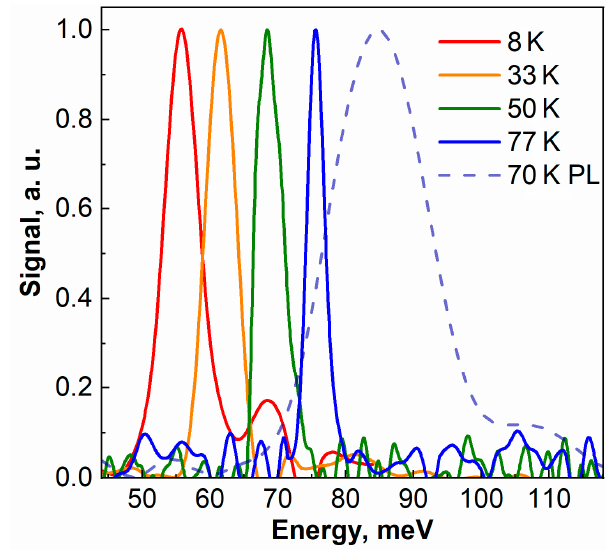
Figure 6. SE and PL spectra for str. #B0225. The SE spectra were obtained under pumping with pulsed CO 2 laser (10.6 wavelength µ m) at pumping intensity of 30 kW/cm 2 (8 K and 33 K) and 100 kW/cm 2 (50 K and 77 К ). The PL spectrum was measured under cw excitation with 808 nm wavelength. All spectra are normalized to 1 for convenience.